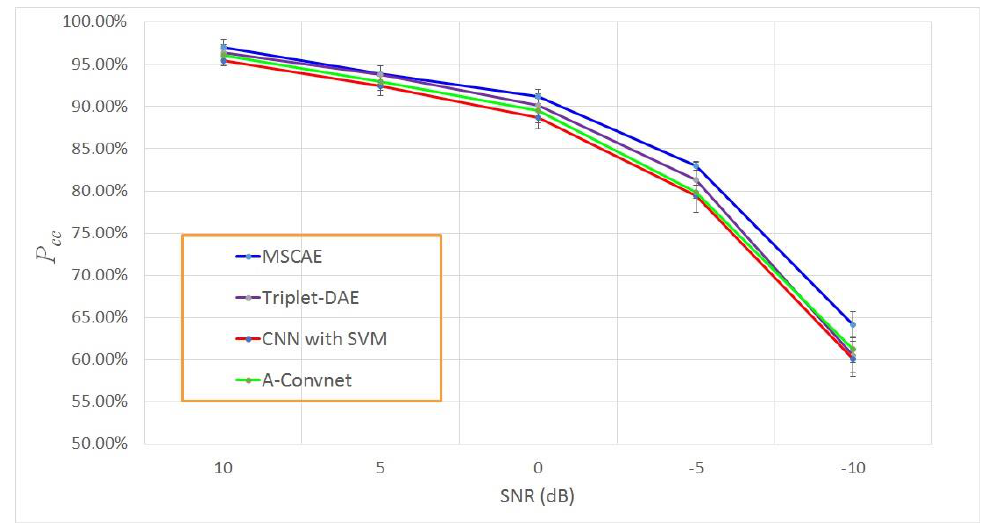
Figure 15. Classification results at different SNR levels.